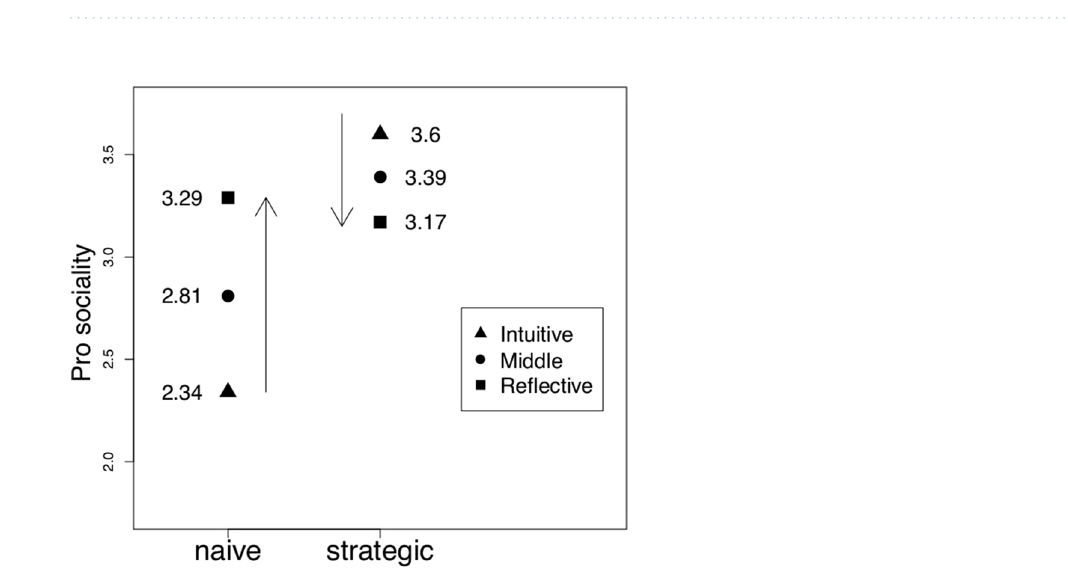
Table 8. Estimated marginal means for DG.